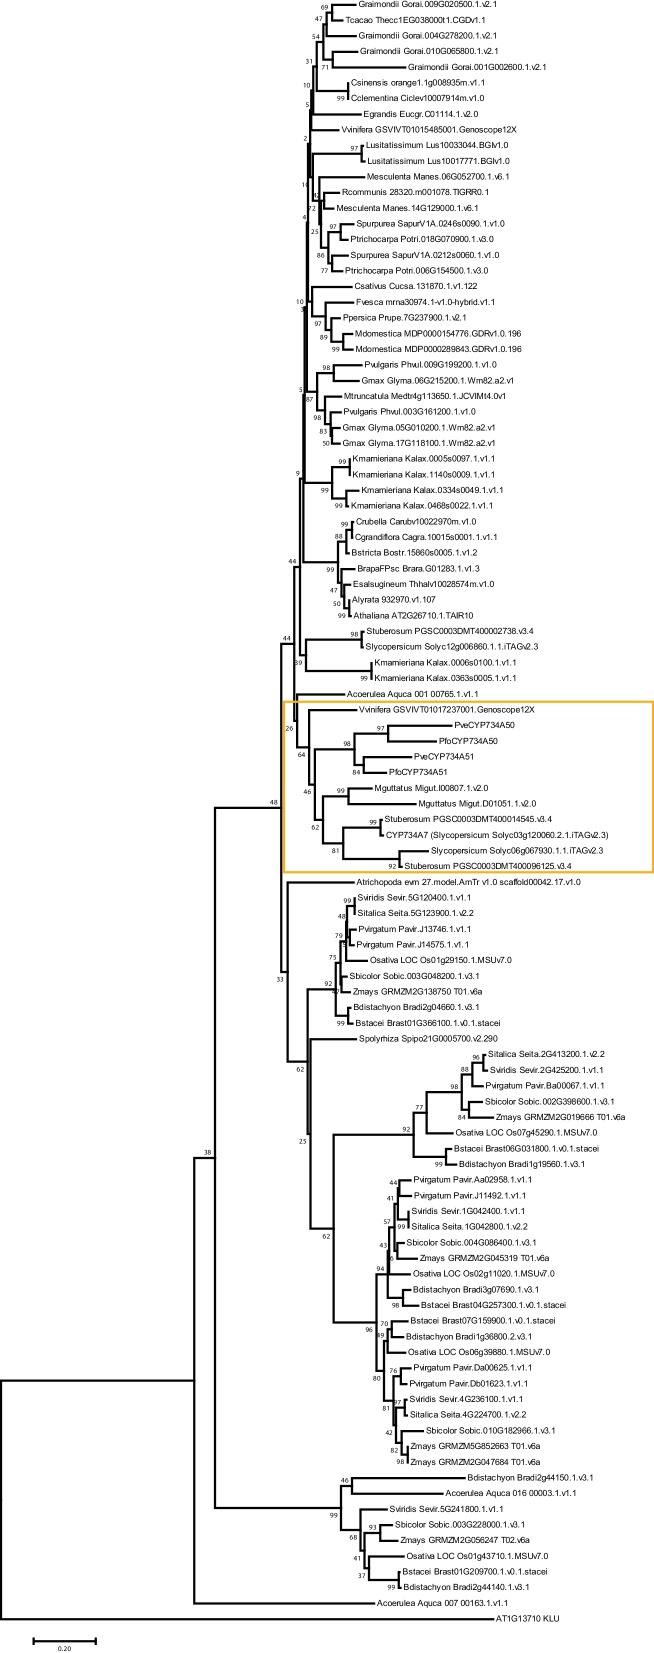
Phylogenetic analysis of CYP734A-like proteins.Molecular phylogeny of CYP734A50-related proteins based on Neighbour Joining. The tree is drawn to scale, with branch lengths proportional to number of substitutions per site. Numbers next to nodes indicate percent support from bootstrap analysis (1000 replicates). A. thaliana KLUH/CYP78A5 was used as outgroup. The subtree shown in Figure 4 is indicated by the orange box.